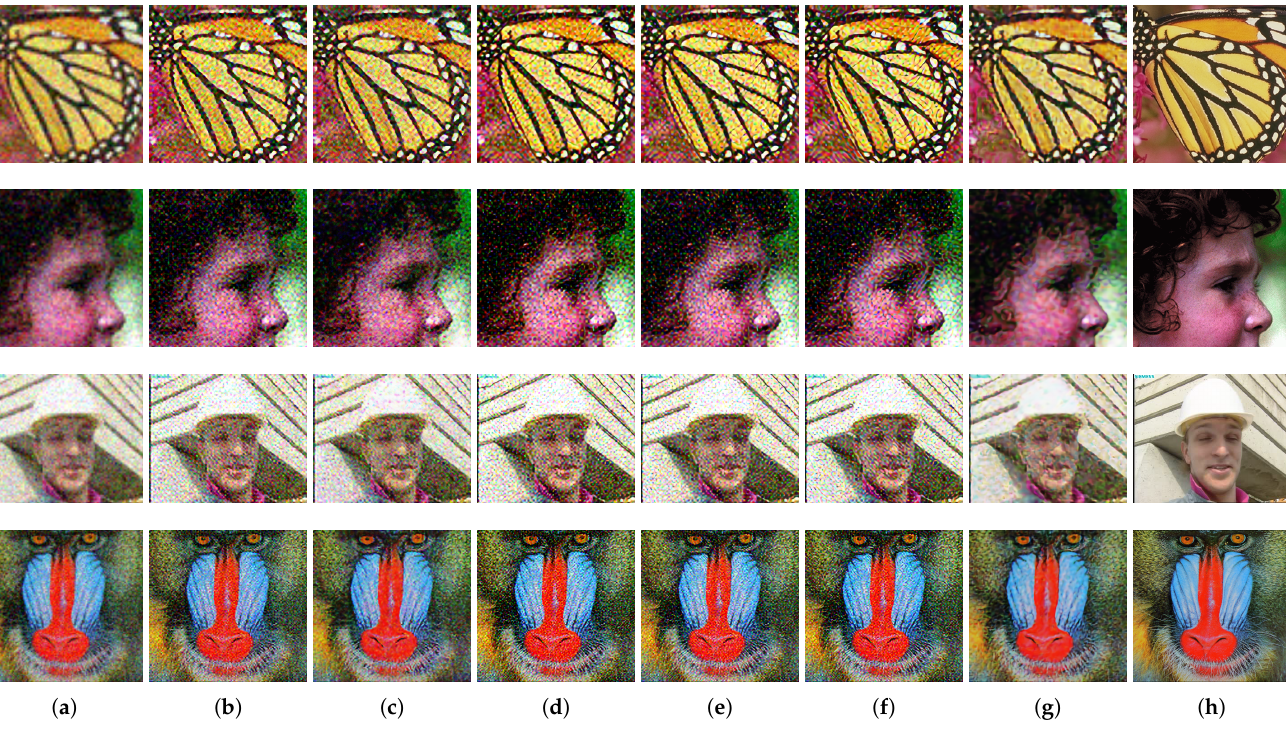
Figure 6. Qualitative comparisons of Set5 [11] and Set14 [12] ( × 4, σ = 25). ( a ) Bicubic, ( b ) DIP-SR [1], ( c ) DIP-Seq, ( d ) DRLN [22], ( e ) HAN [32], ( f ) SAN [33], ( g ) Ours and ( h ) Ground